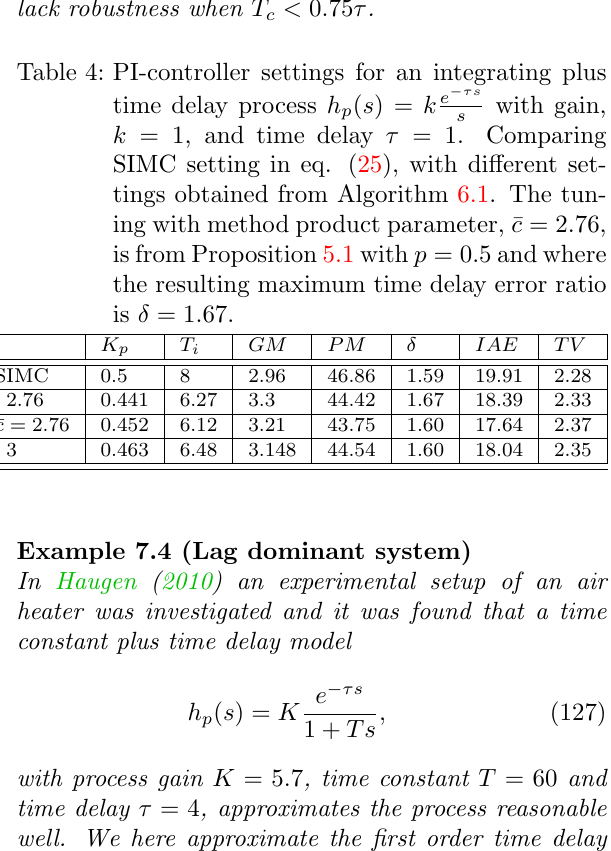
Table 6: PI-controller settings for an integrating plus